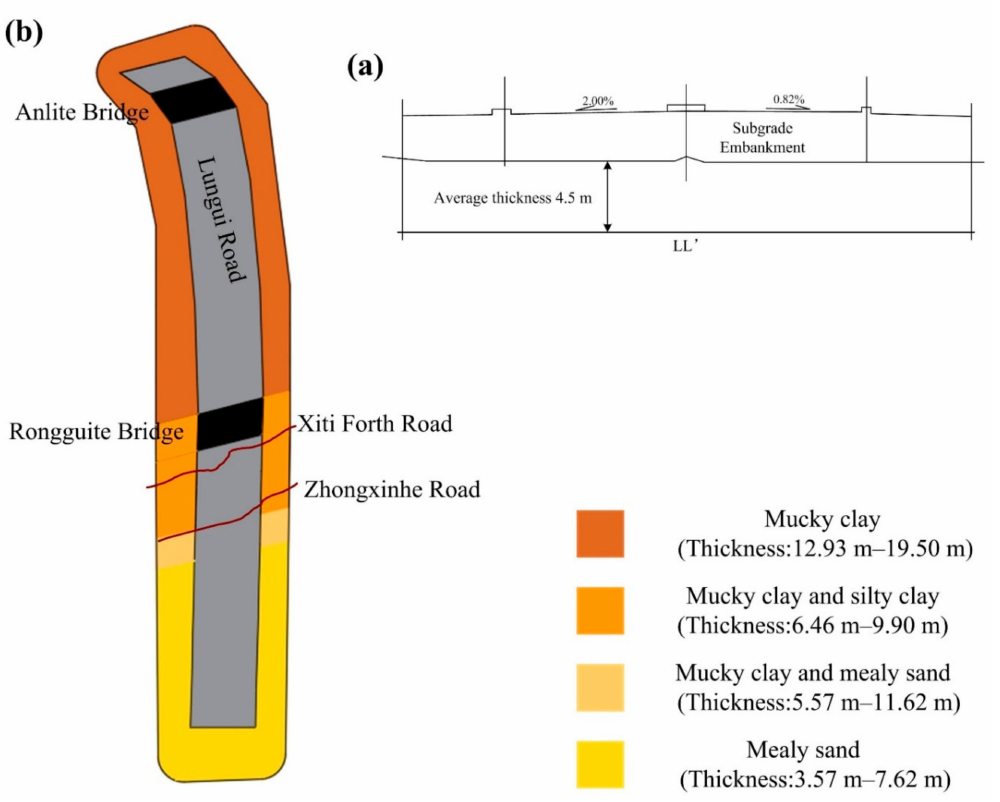
Figure 4. ( a ) Transversal profile at LL’ in Figure 3a and ( b ) geological distribution of the soft soil along the longitudinal direction of the Lungui